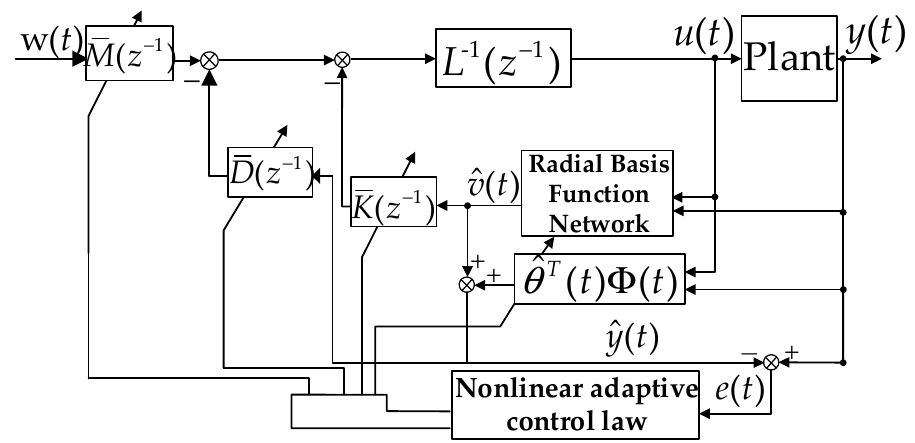
Figure 6. Nonlinear adaptive controller structure.